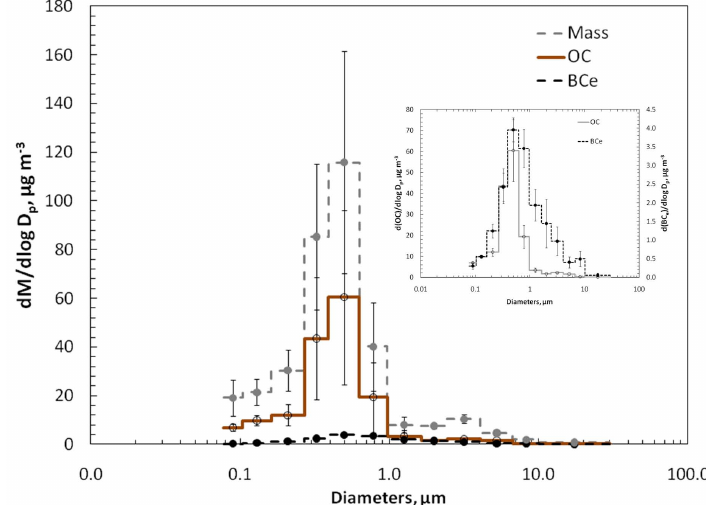
Fig. 8. Size distribution of the average mass, OC and BC e concentrations. To show the size distributions of OC and BC e more clearly, they are shown at different scales in the insert. The size distribution for the mass concentrations are the average for all samples collected on aluminum foil substrates during the dry period ( n = 6). The size distribution for OC and BC e concentrations were collected on quartz fiber filters ( n = 5). Error bars here represent the standard error (standard deviation divided by the number of